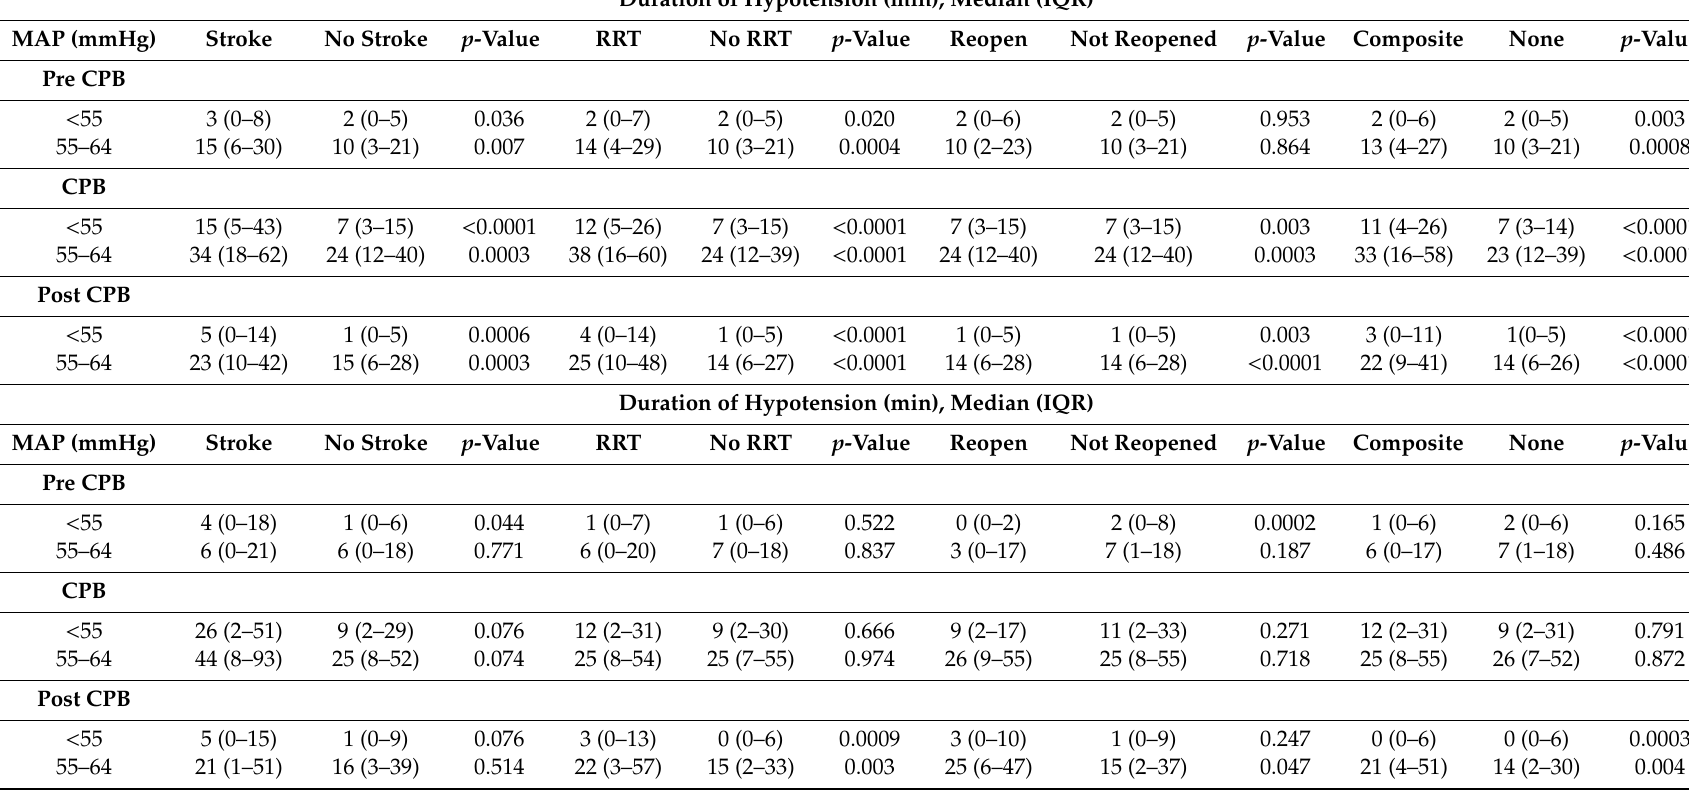
Table A2. Median durations of hypotension before, during and post cardiopulmonary bypass in intermediate-risk patients who developed postoperative complications vs. those who did not. Median durations of hypotension before, during and post cardiopulmonary bypass in high-risk patients who developed postoperative complications vs. those who did